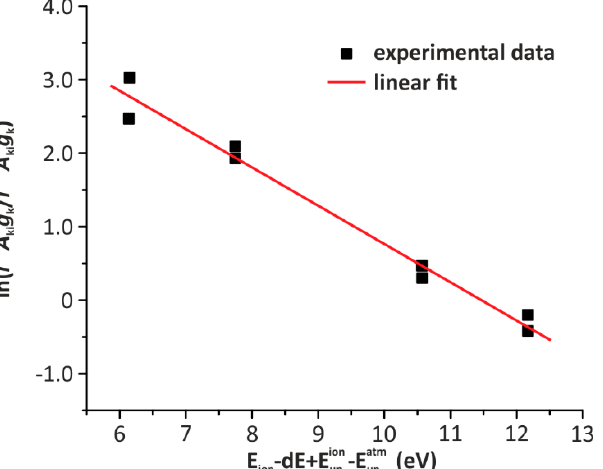
Figure 6. Saha–Boltzmann plot for calculating ionization temperature from the data of sample S_1.